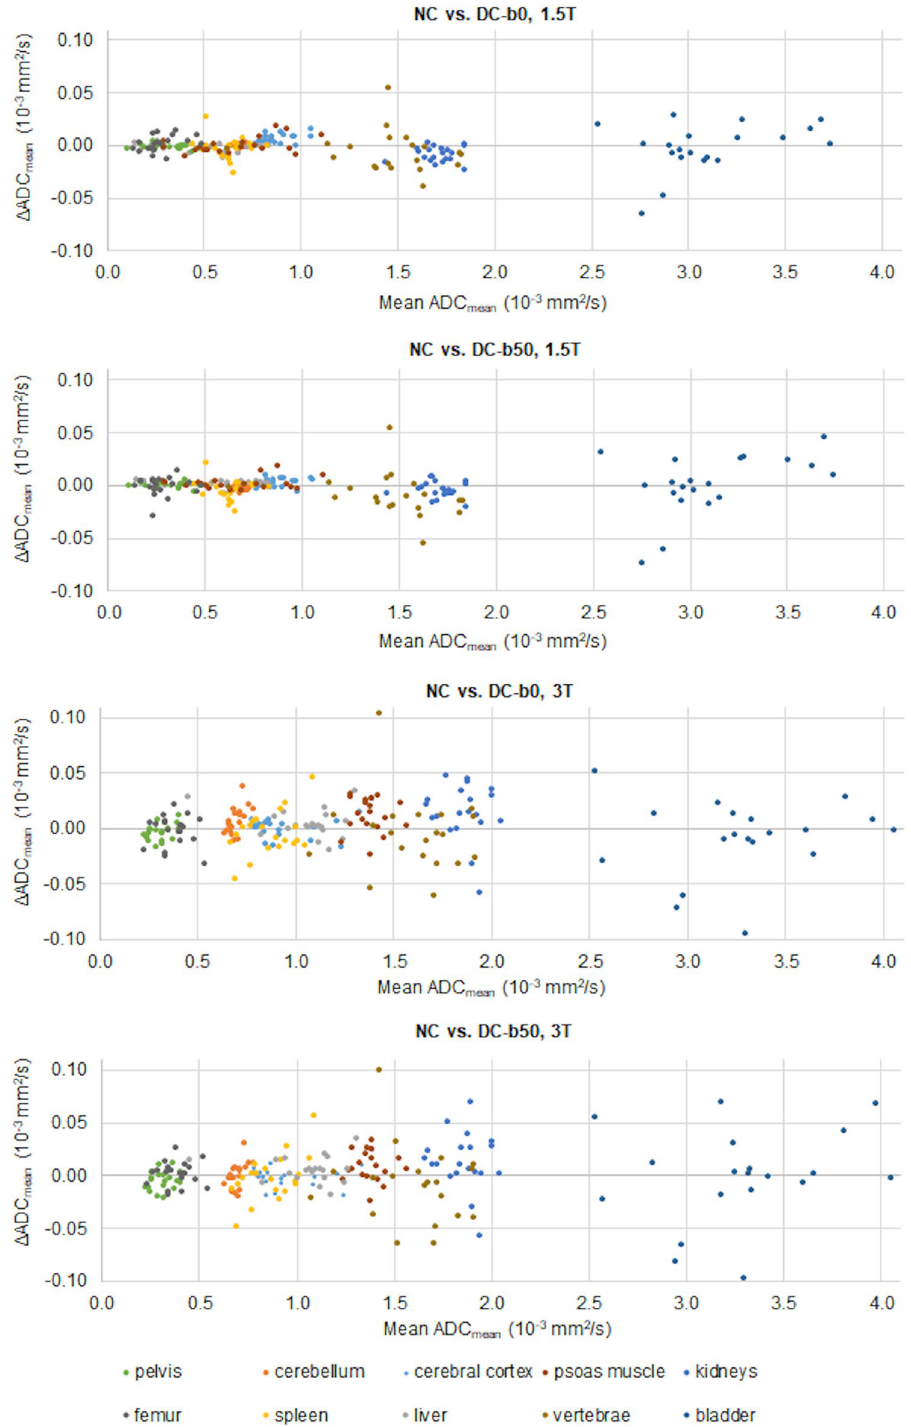
Figure 4. Bland Altman plots of the difference in ADC mean (ΔADC mean ) of healthy tissues measured between non-corrected (NC) and b0-based distortion corrected (DC-b0) data, and between NC and b50-based distortion corrected (DC-b50) data, at 1.5T and 3T. For the pelvis the body of ilium was